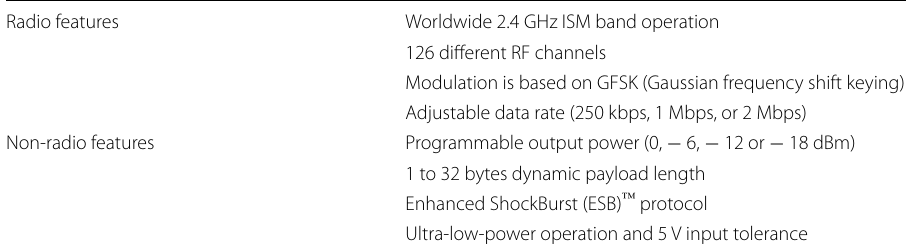
module main features [24] +